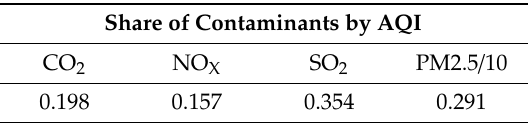
Table 5. Shares of analyzed pollutants according to AQI coe ffi cient.